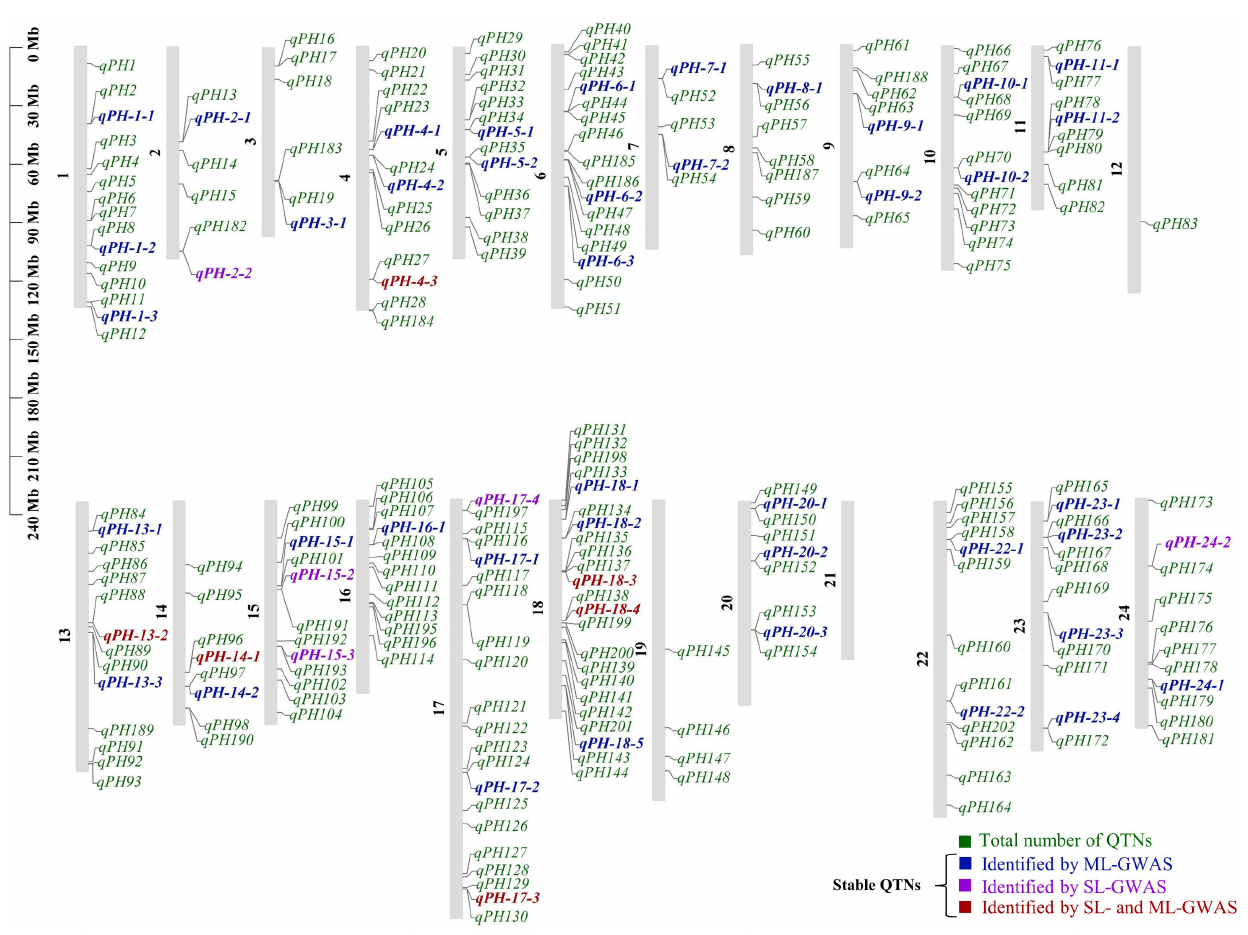
Figure 3. Genetic map based on identified QTNs in tobacco detected in different environments by multi-locus and single-locus methods. The green font represents the total number of QTNs. Blue, purple, and brown indicate stable QTNs detected by ML models only, SL models only, and ML- and SL-models across at least two environments and/or methods, respectively.